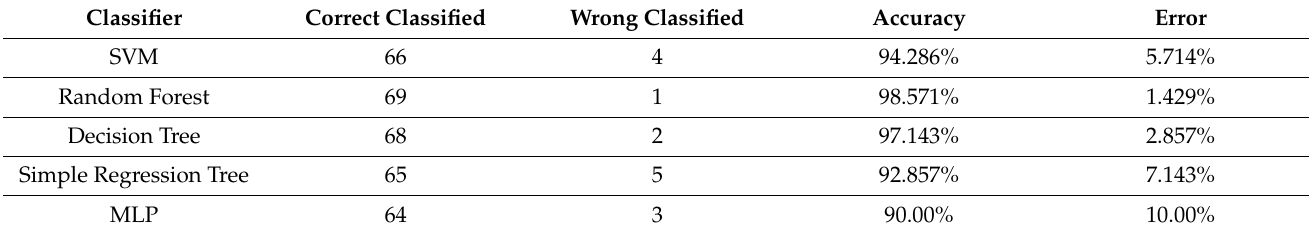
Table 6. Confusion matrix for KNIME classifiers.